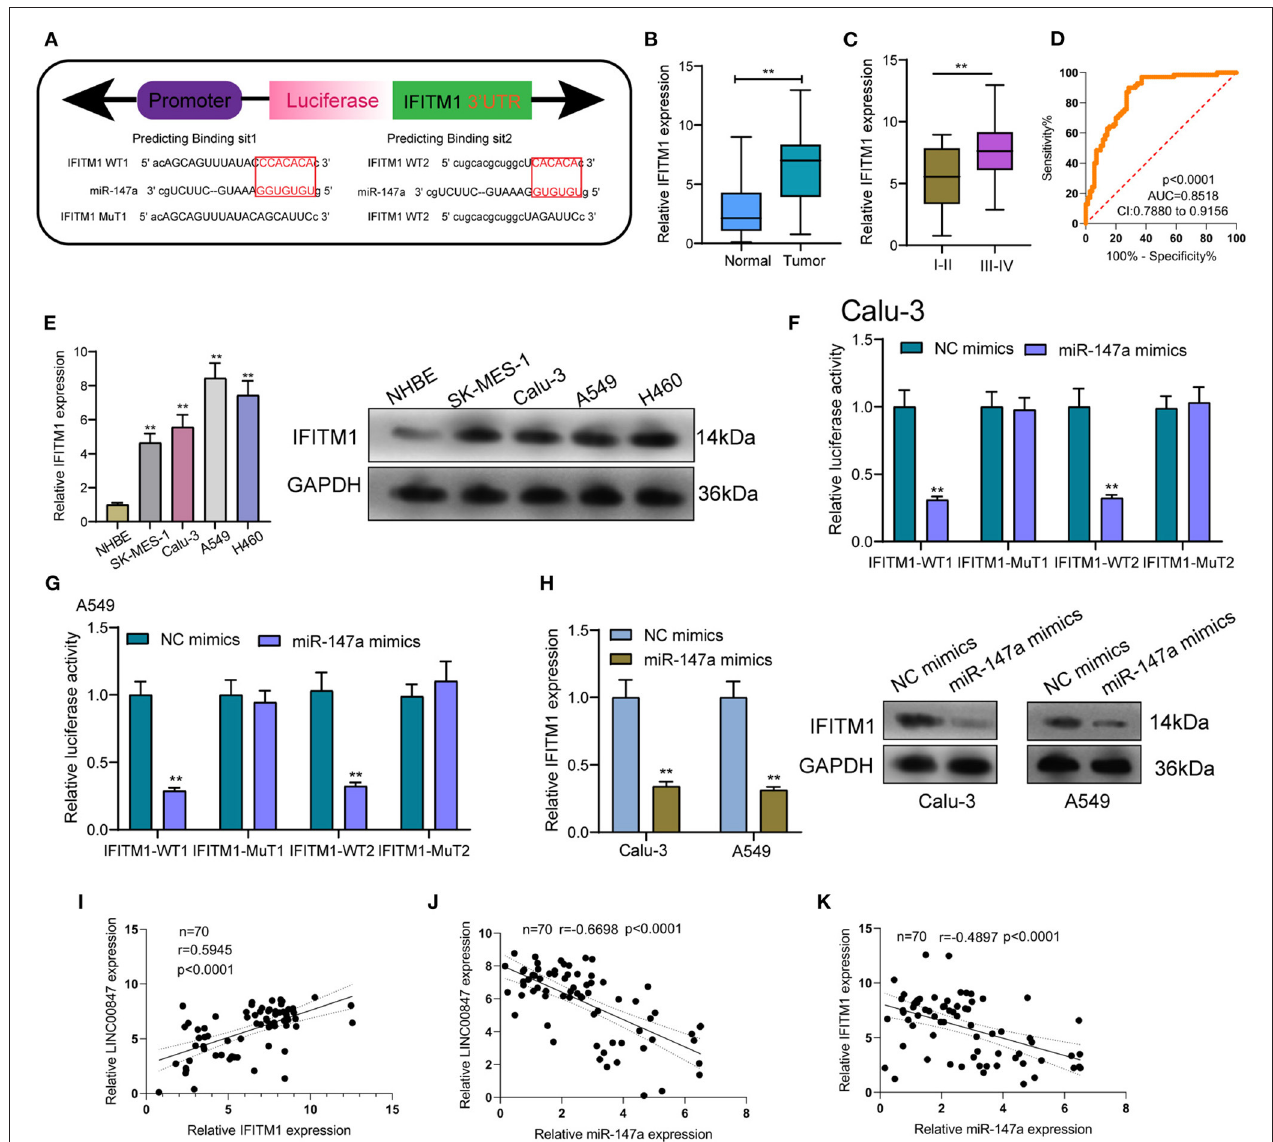
FIGURE 6 | IFITM1 is a direct target of miR-147a. (A) Seed sequences of miR-147a against the wild-type or mutant 3’-UTR of IFITM1. (B) Expression levels of IFITM1 in clinical specimens of NSCLC. (C) The levels of IFITM1 in NSCLC specimens with different stages. (D) The area under the ROC curve was 0.8518. (E) the protein level of IFITM1 was increased in four NSCLC cell lines. (F, G) Relative luciferase activity was detected by luciferase assays in Calu-3 and A549 cells. (H) IFITM1 levels were increased after overexpression of miR-147a. (I–K) The correlation among LINC00847, miR-147a and IFITM1 expressions in our cohort was determined by Spearman’s correlation analysis. **p <